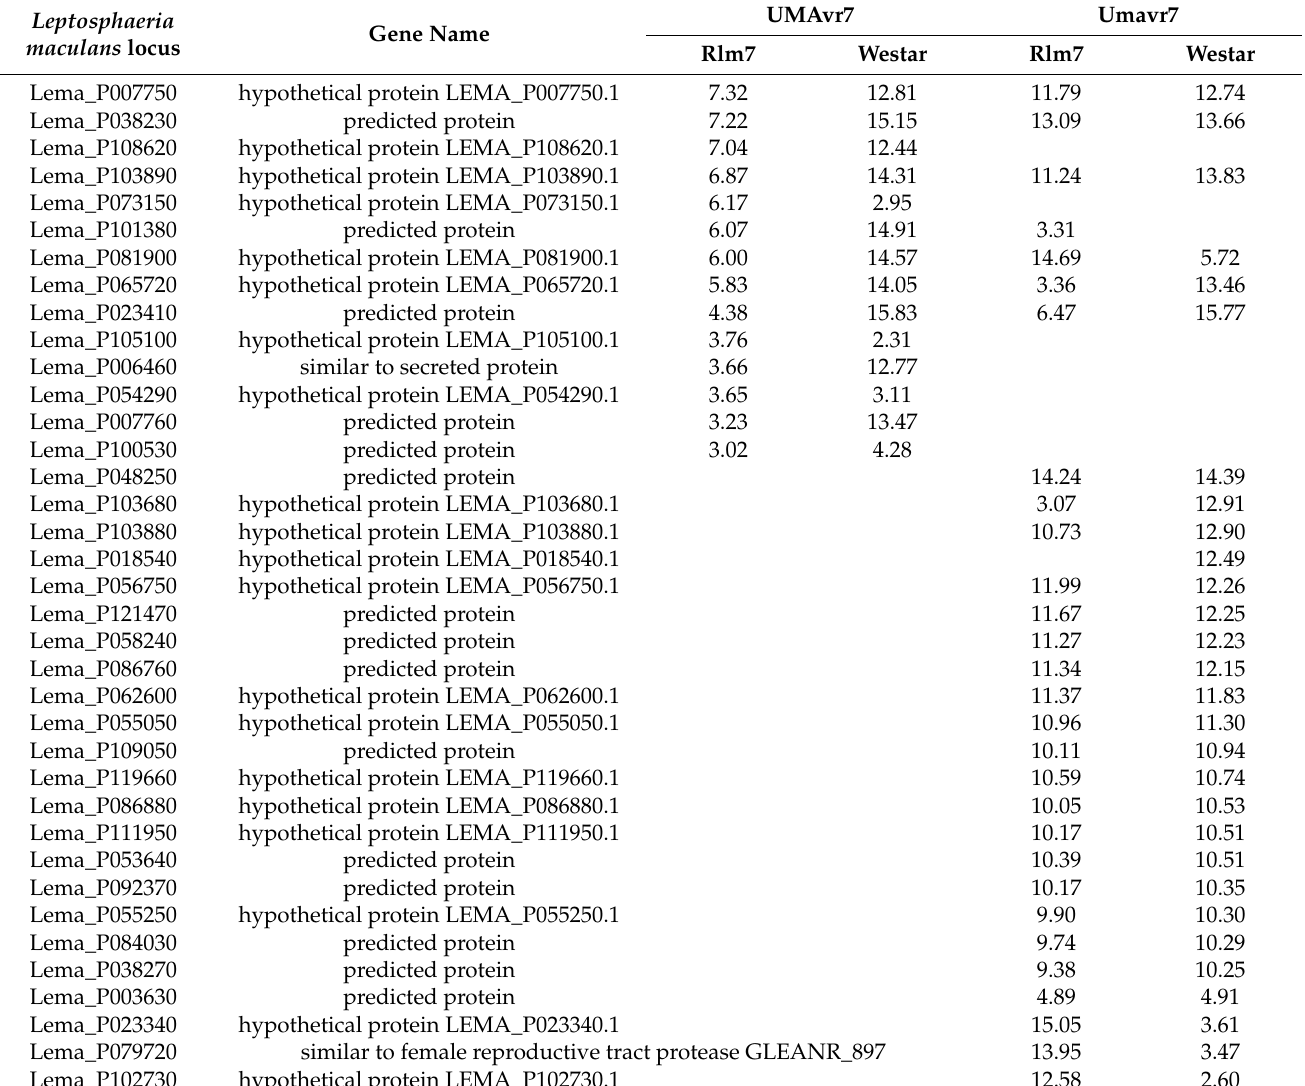
Table 1. Leptosphaeria maculans effector genes differentially expressed only at 11-dpi (necrotrophic stage) compared to 0-dpi. Name of effector gene, and log fold-change expression of each gene under each interaction are shown. Results are representative of three biological replicates. The results were considered at the fold-change cutoff (logFC) of ≥ 1 and ≤− 1 and false discovery rate (FDR) of ≤